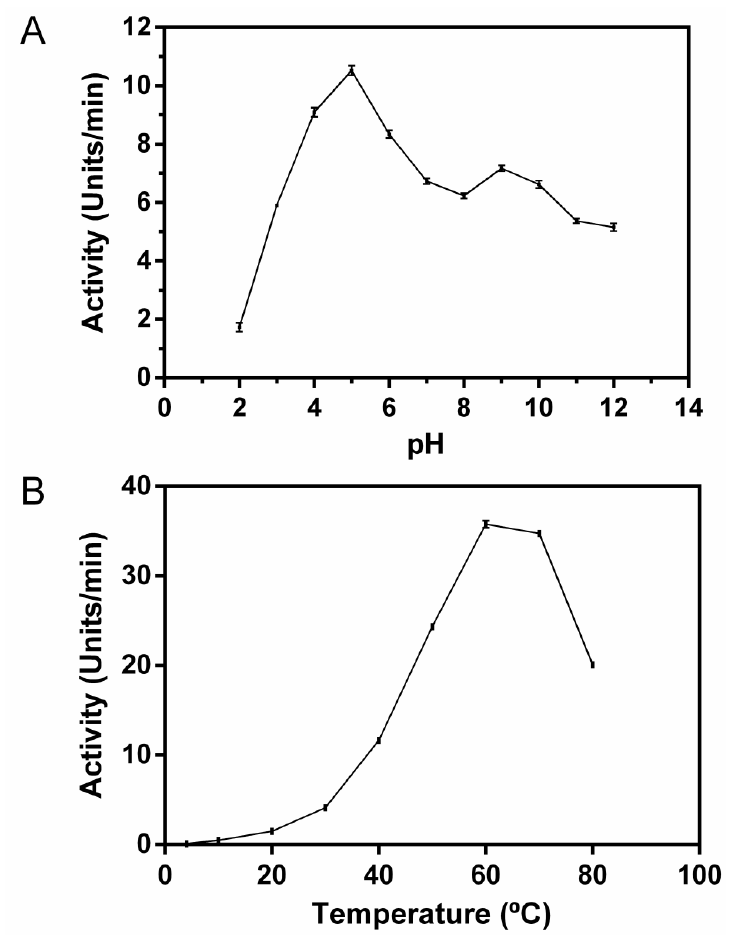
Figure 6. Effects of pH and temperature. ( A ) Effect of pH on the azocaseinolytic assay of fraction F1.0. The fraction F1.0 of C. urens (200 µg) was pre-incubated for 15 min at different pH (2.0, 3.0, 4.0, 5.0, 6.0, 7.0, 8.0, 9.0, 10.0, 11.0 and 12.0), followed by incubation with azocasein (1%) for 30 min at 37 °C in the same conditions; ( B ) Effects